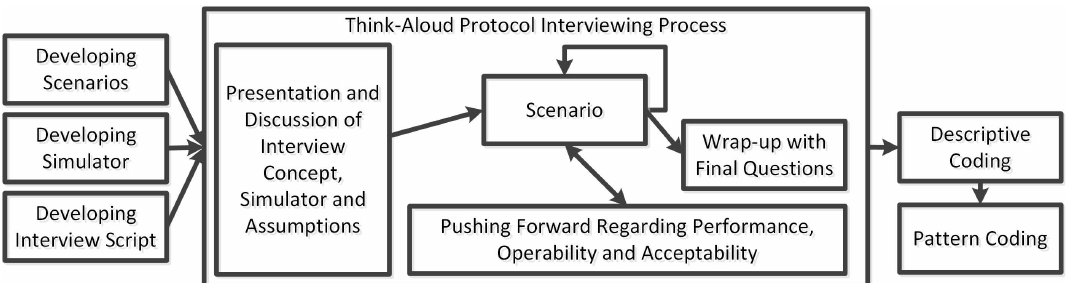
Figure 1. The Data Collection and Analysis